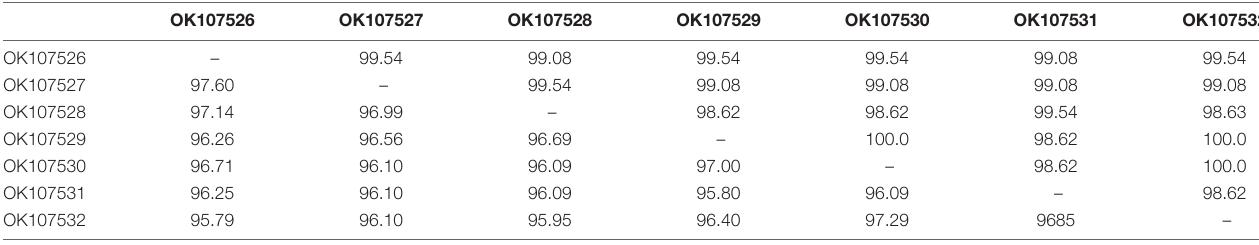
TABLE 4 | Percentage identity of RNA3 CMV isolates from natural host plants in Nigeria.